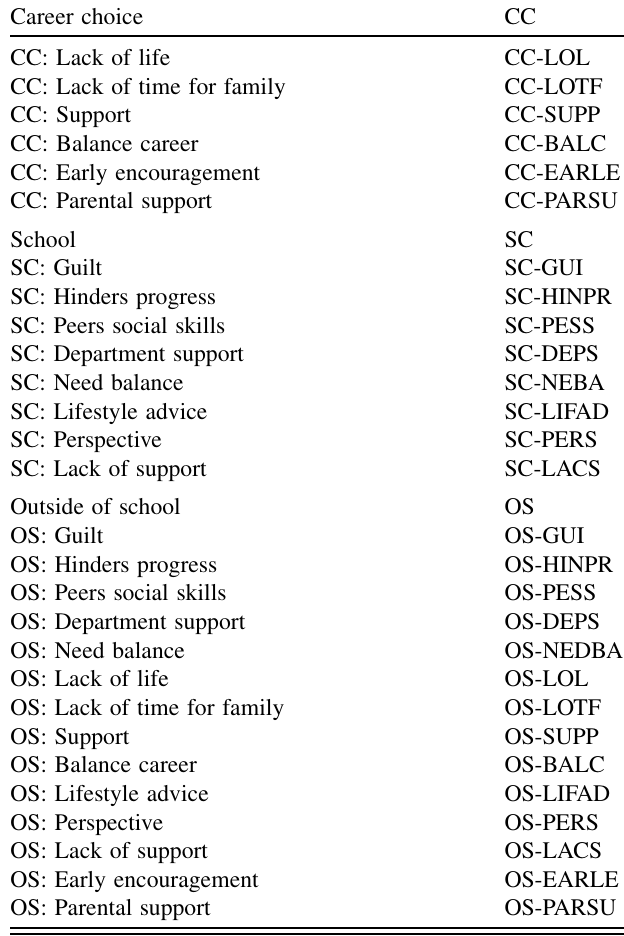
TABLE II. Preliminary code list based on existing literature. This was a means to help further aggregate and decipher the themes within the data.